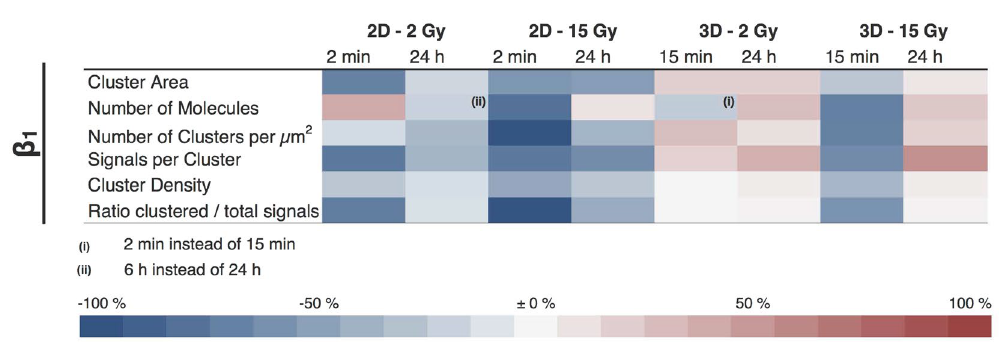
Figure 5. Percentual change of various parameter after IR of β 1 integrins of 2D and 3D cultured MEF